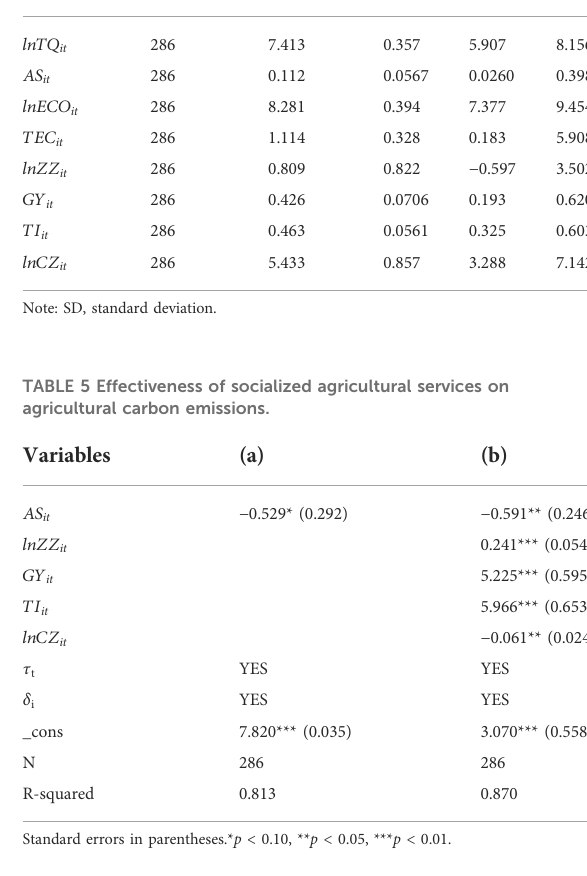
Table 1 indicator measures, taking the natural logarithm